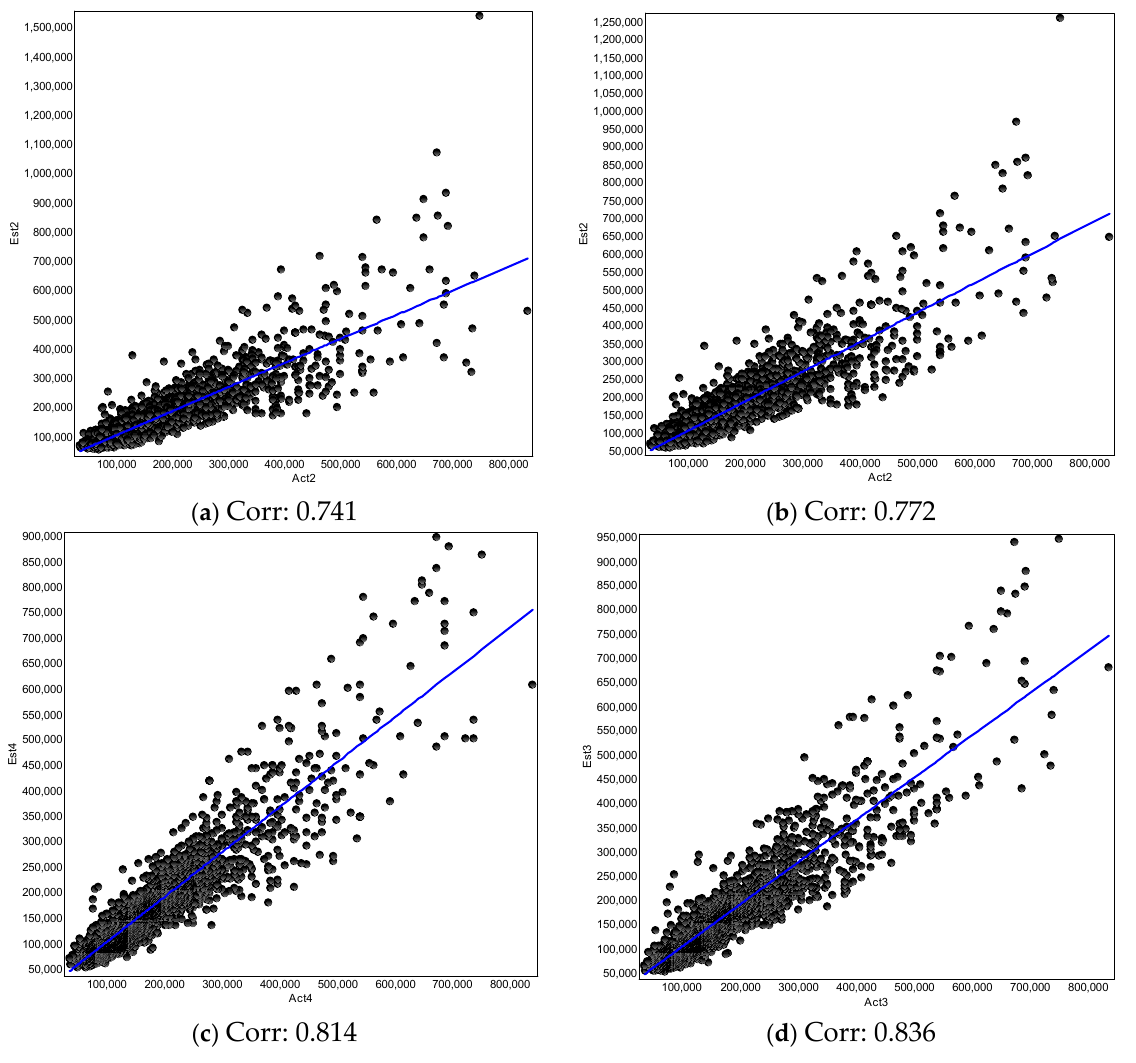
Figure 5. Scatterplots of observed house vs. predicted prices. ( a ) MRA model. ( b ) Elastic ‐ net model. ( c ) MRA ESF model. ( d ) Elastic ‐ net ESF model.